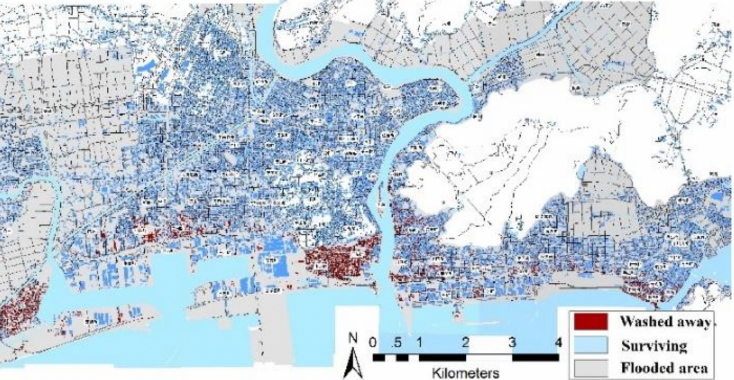
Figure 4. The ground-truth map interpreted by Tohoku University and the University of Tokyo [36].